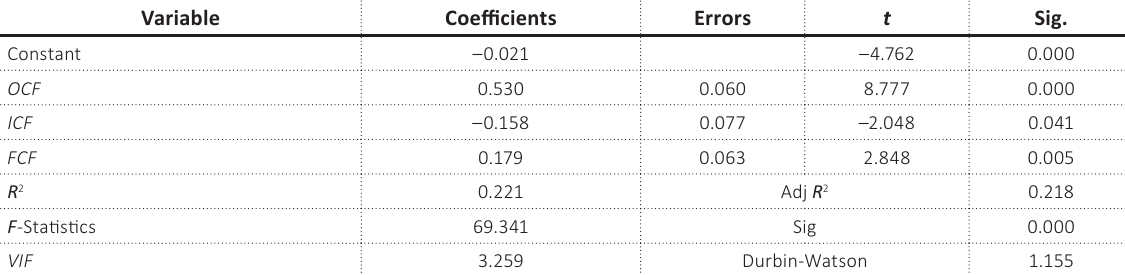
Table 3. OLS regression results